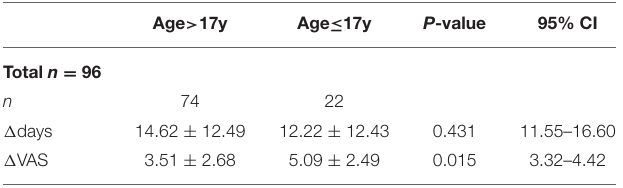
TABLE 4 | Divided by age ( > 17y or ≤ 17y) with changes in the frequency ( 1 days) and intensity of headaches ( 1 VAS) in group of surgical intervention after a long-term follow-up.